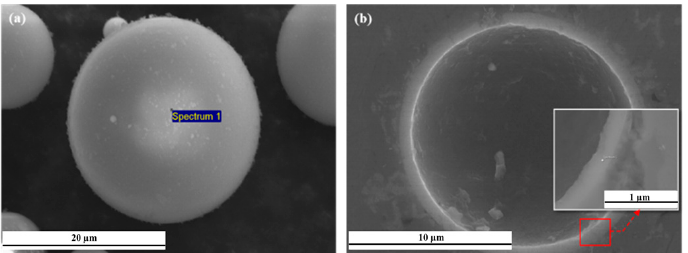
Figure 9. SEM and corresponding EDS point profiling of the GHS: ( a ) SEM of the GHS; ( b ) SEM images of the GHS after sintering. Table 5. EDS results for GHS before sintering.